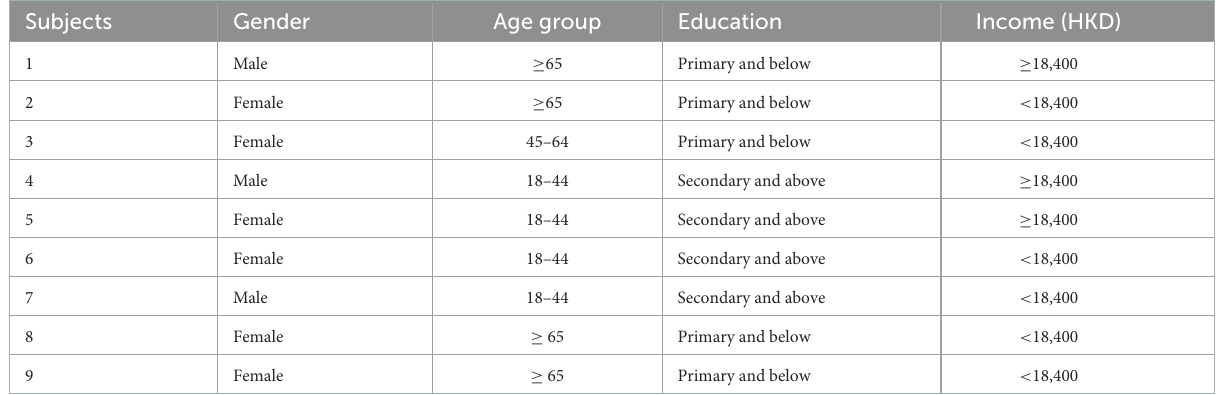
TABLE 1 Characteristics of